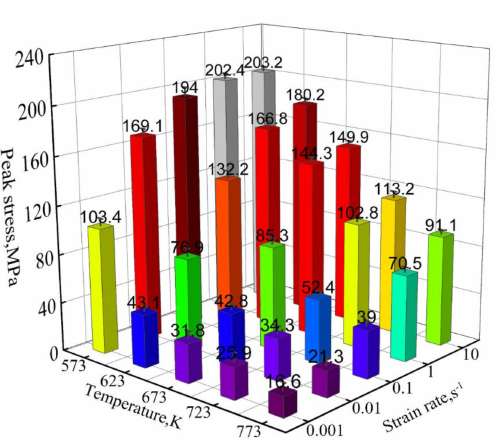
Figure 3. Peak flow stress of the Mg-2.5Nd-0.5Zn-0.5Zr alloy at different deformation